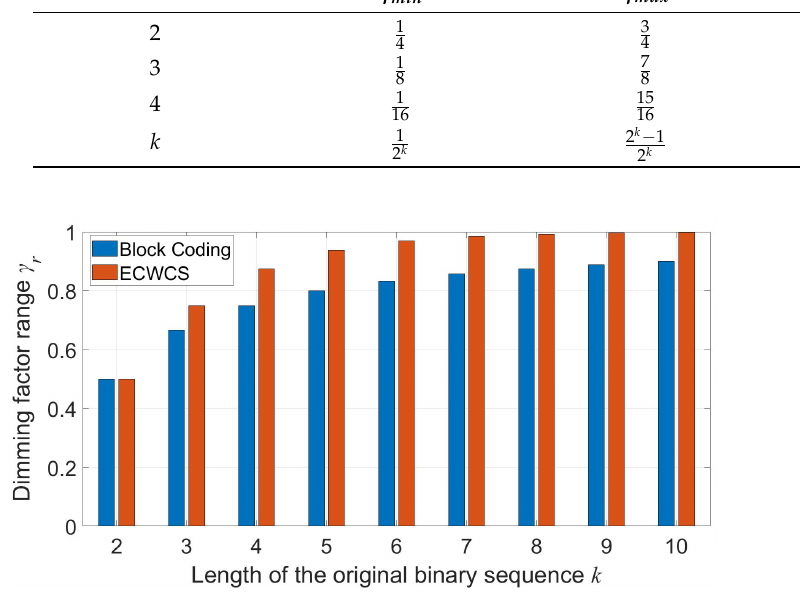
Figure 2. Dimming range of the block coding scheme and the extensional constant weight codeword sets (ECWCS) scheme under different k